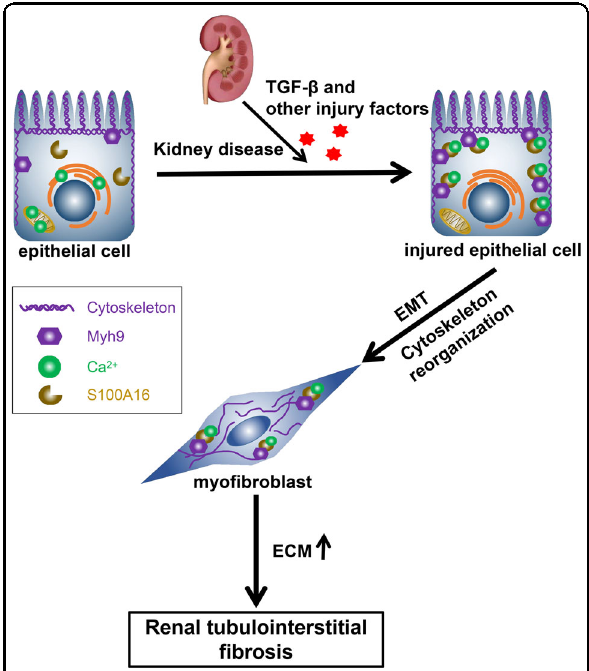
Fig. 8 Schematic diagram showing the EMT and cytoskeleton reorganization induced by the combined actions of S100A16, Myh9, and Ca 2 + . Kidney disease, TGF- β , and other injury factors result in combined actions of S100A16, Myh9, and Ca 2 + in injured epithelial cells. The EMT and cytoskeleton reorganization lead to the transition of renal epithelial cells into myo fi broblasts, followed by accumulation of extracellular matrix and aggravation of renal tubulointerstitial fi